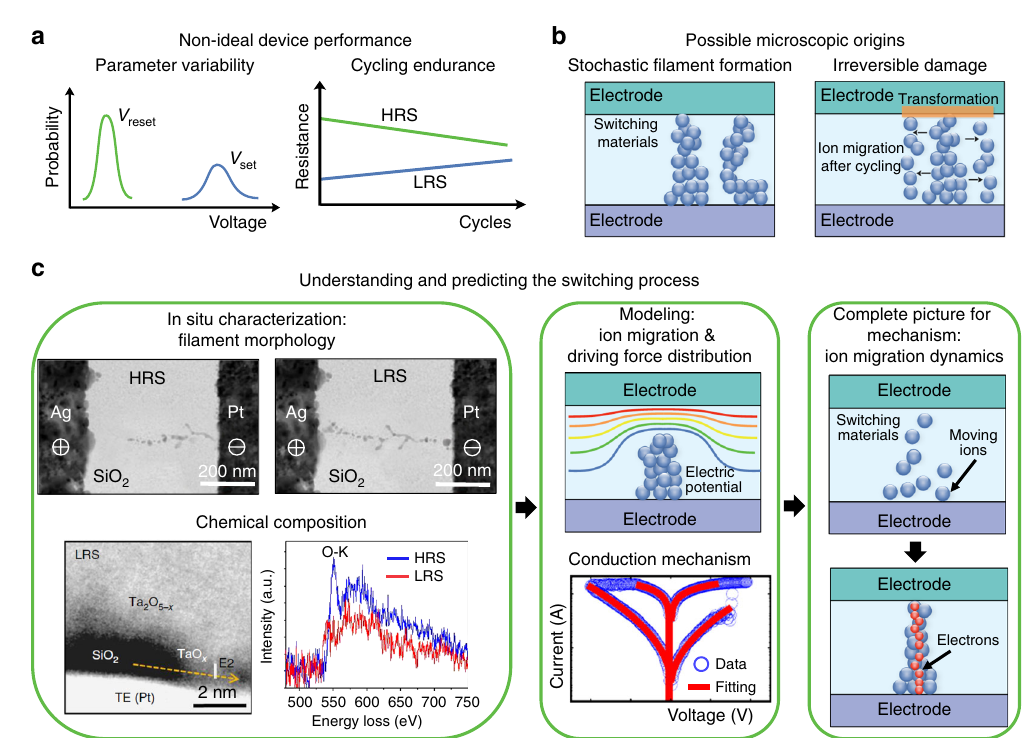
Fig. 1 Synergistic approaches for mechanistic research of memristive devices for improving the device performance. a Parameter variability of the set and reset voltages (left), and typical endurance failure behaviors in memristors (right). HRS represents the high resistance state, and LRS represents the low resistance state. b Possible microscopic origins responsible for the device behaviors: conduction fi laments in different forms contribute to the parameter variability (left of panel a ); after cycling operation, the formation of an interfacial layer with high series resistance (orange disc), or the expansion of migration area for mobile ions (migrated blue balls marked by black arrows), leading to the cycling endurance failure (right of panel a ). c The in situ characterizations and device modeling can complement and complete each other and together provide a holistic picture of the resistive switching, as shown in the middle where a device model is schematically presented with switching I – V loops of simulated and experimental data. Reproduced from ref. 12 , Macmillan Publishers Ltd ( c ), Ag/SiO 2 /Pt device; ref. 22 , Macmillan Publishers Ltd ( c ), Ta 2 O 5-x /SiO 2 /Pt device